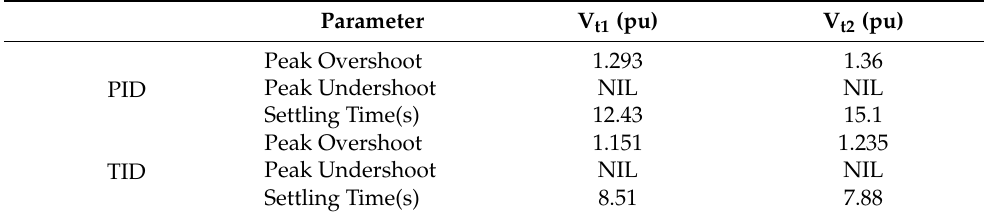
Table 18. Comparison of AVR dynamics for PID and TID